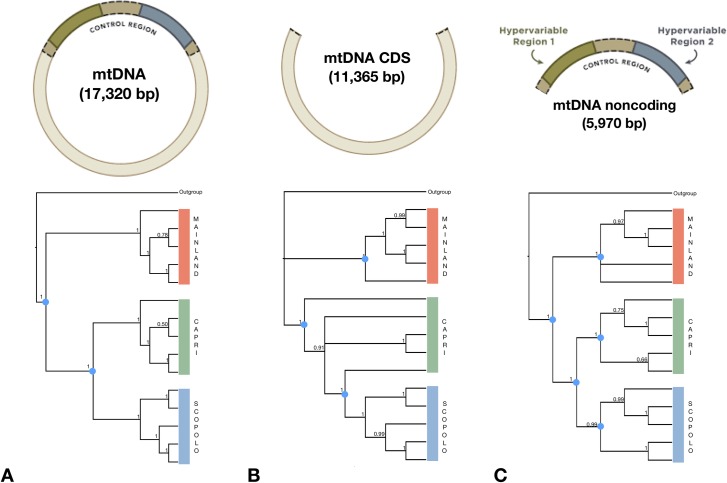
Phylogenetic Bayesian tree of the all populations based on complete mitochondrial DNA sequences (A); coding regions (B) and noncoding regions (C). The tree was rooted using the mtGenome of Podarcis siculus from Sicily (accession number NC_011609). Bayesian posterior probabilities are indicated at nodes. Colours of subclades indicate populations from mainland (orange), Capri (green) and Scopolo (azure).